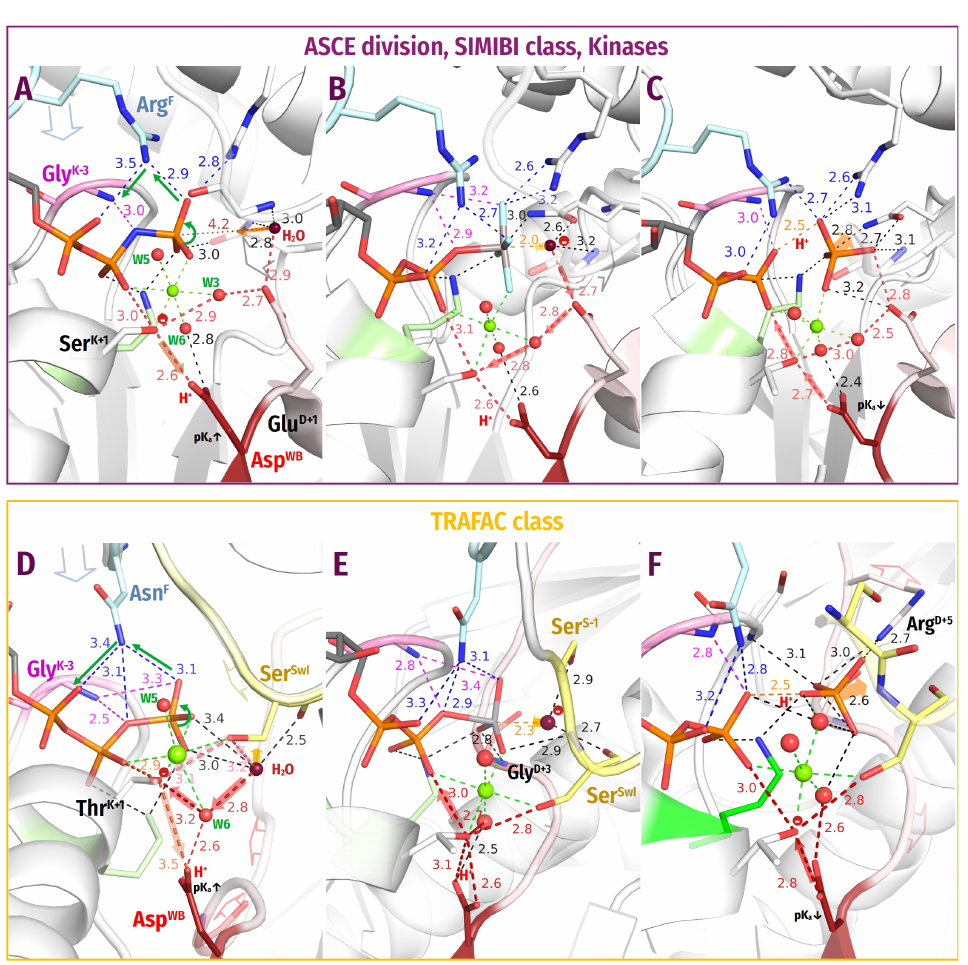
Figure 11. Two tentative mechanisms of proton transfer from W cat to Asp WB in P-loop NT- Pases. The shade of the red arrows of proton transfers varies through panels ( A – F ) to emphasize that the kinetic coupling of these steps with each other and reactions in the catalytic site could vary depending on the thermodynamics of particular enzymes. Other colours as in Figures